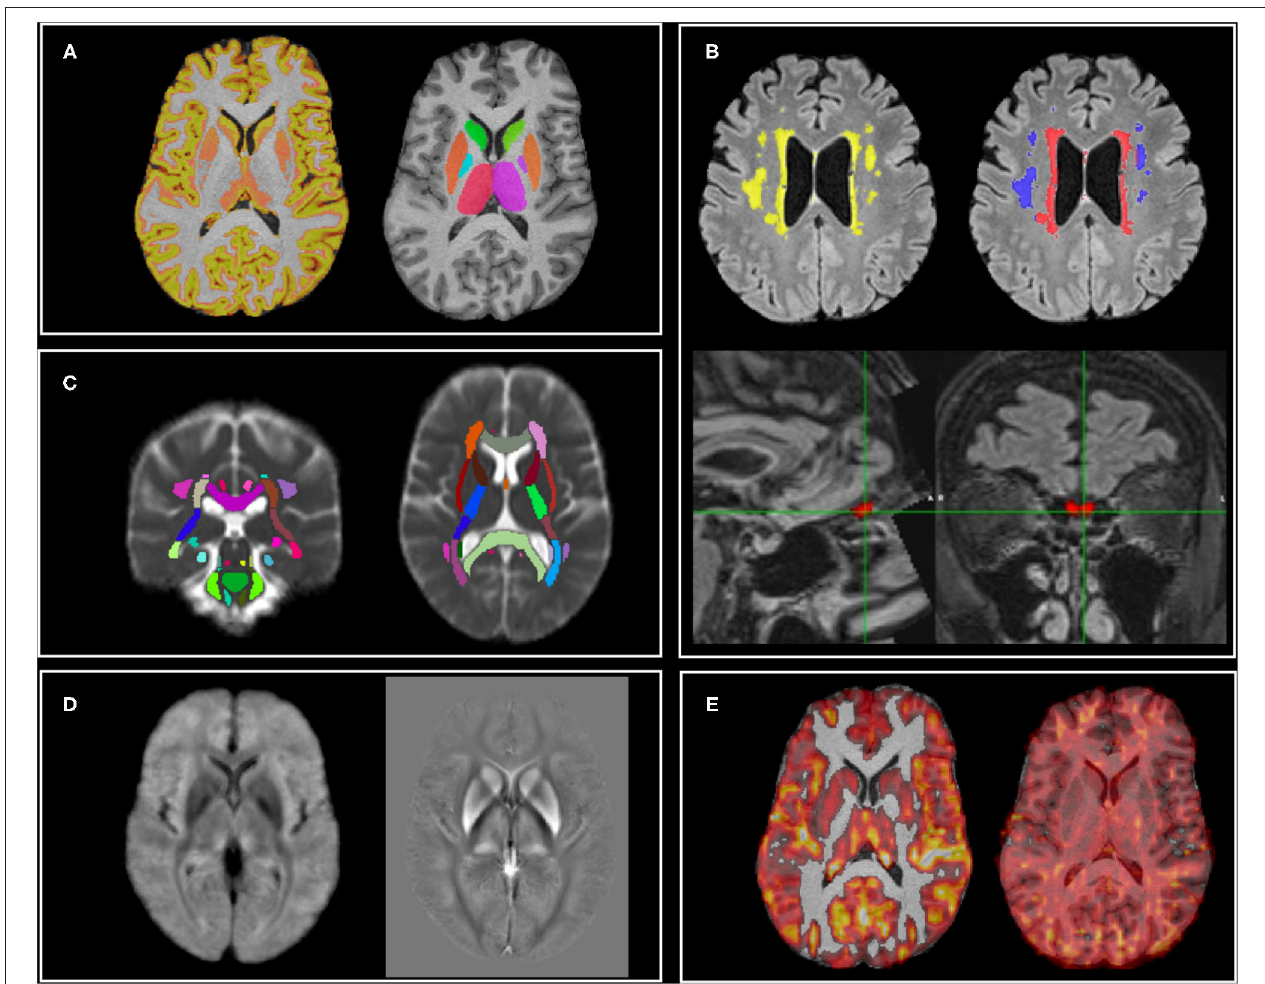
FIGURE 1 | MRI modalities and examples of outputs of the analysis pipeline. (A) T1: cortical volumes (left—GM partial volume estimate shown as example) and subcortical volumes (right); (B) T 2 -FLAIR: white matter hyperintensities (total in yellow, periventricular in red, deep in blue) and olfactory bulb volume and intensity; (C) dMRI: mean diffusivity of major white matter tracts (average MD image across subjects shown for display purposes); (D) Susceptibility weighted imaging (average images across subjects shown for display purposes): T * 2 (left) and QSM (right); (E) ASL: non-partial volume corrected cerebral blood flow (left—lower threshold set to 20 ml/100 g/min for display purposes) and arterial transit time